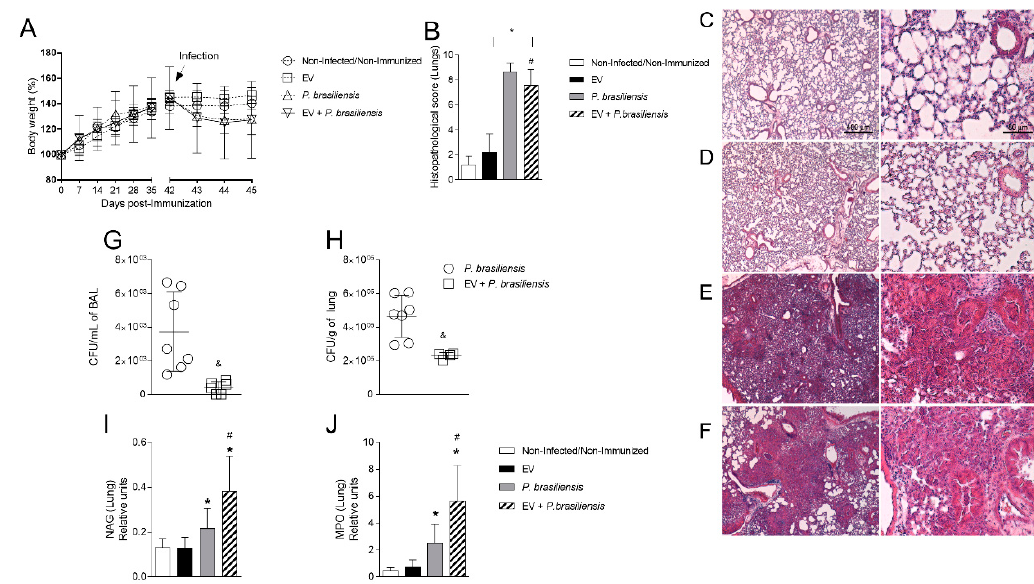
Figure 2. Immunization with EVs from P. brasiliensis alters tissue architecture and reduces fungal burden in the lung tissue and the inflammatory profile of lung tissue 72 h post-infection. Body weight ( A ). Histopathological score ( B ). Lung histology (( C – F ), scale bars—left 400 µ m and right 20 µ m)—non-infected/non-immunized group ( C ), EV group ( D ), P. brasiliensis group ( E ), EV + P. brasiliensis group ( F ). Fungal burden in BAL ( G ). Fungal burden in lung tissue ( H ). NAG ( I ). MPO ( J ). & p ≤ 0.05 compared to P. brasiliensis group. * p ≤ 0.05 compared to non-infected/non-immunized and EV groups. # p ≤ 0.05 compared to P. brasiliensis group. Non-infected/non-immunized (control). Immunization for 42 days with two doses of 1000 ng of EV protein with adjuvant (boost dose, without adjuvant, given 14 days after the first dose). Data represents the mean of two independent experiments. n = 8 animals per group.